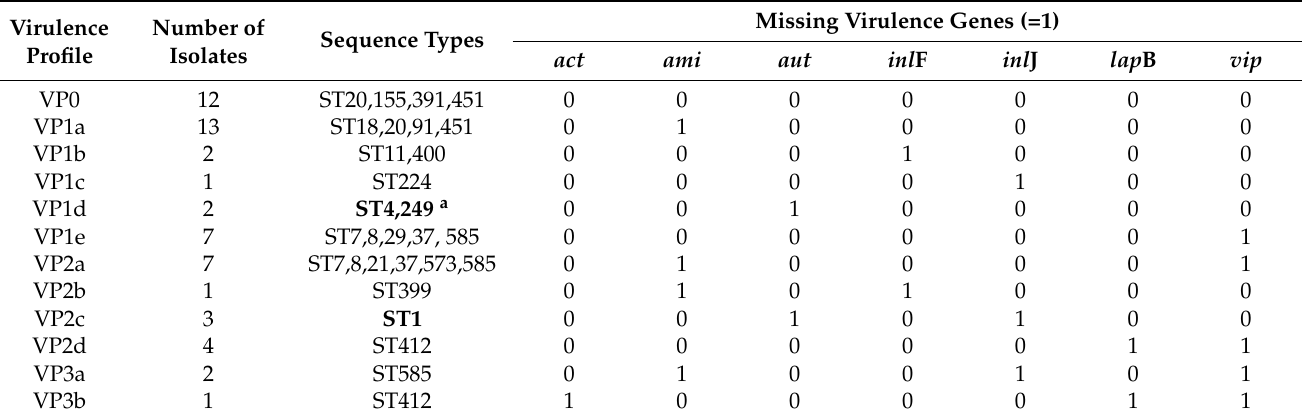
Table 5. Virulence profiles detected among 55 Listeria monocytogenes